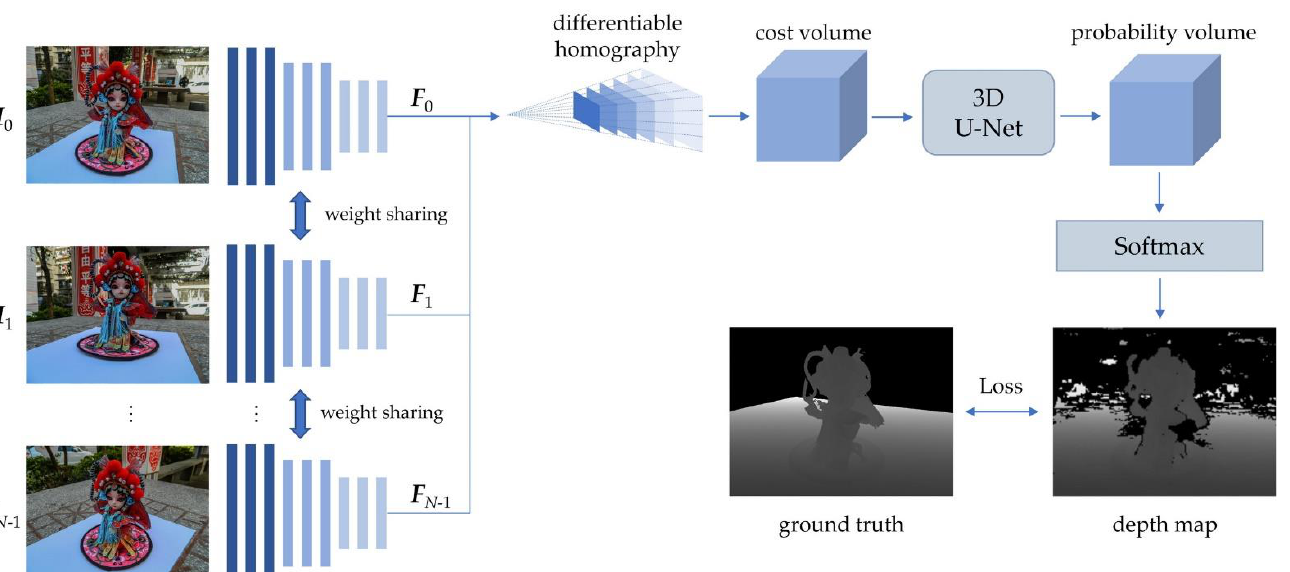
Table 1. Detailed architecture of the feature extraction network.